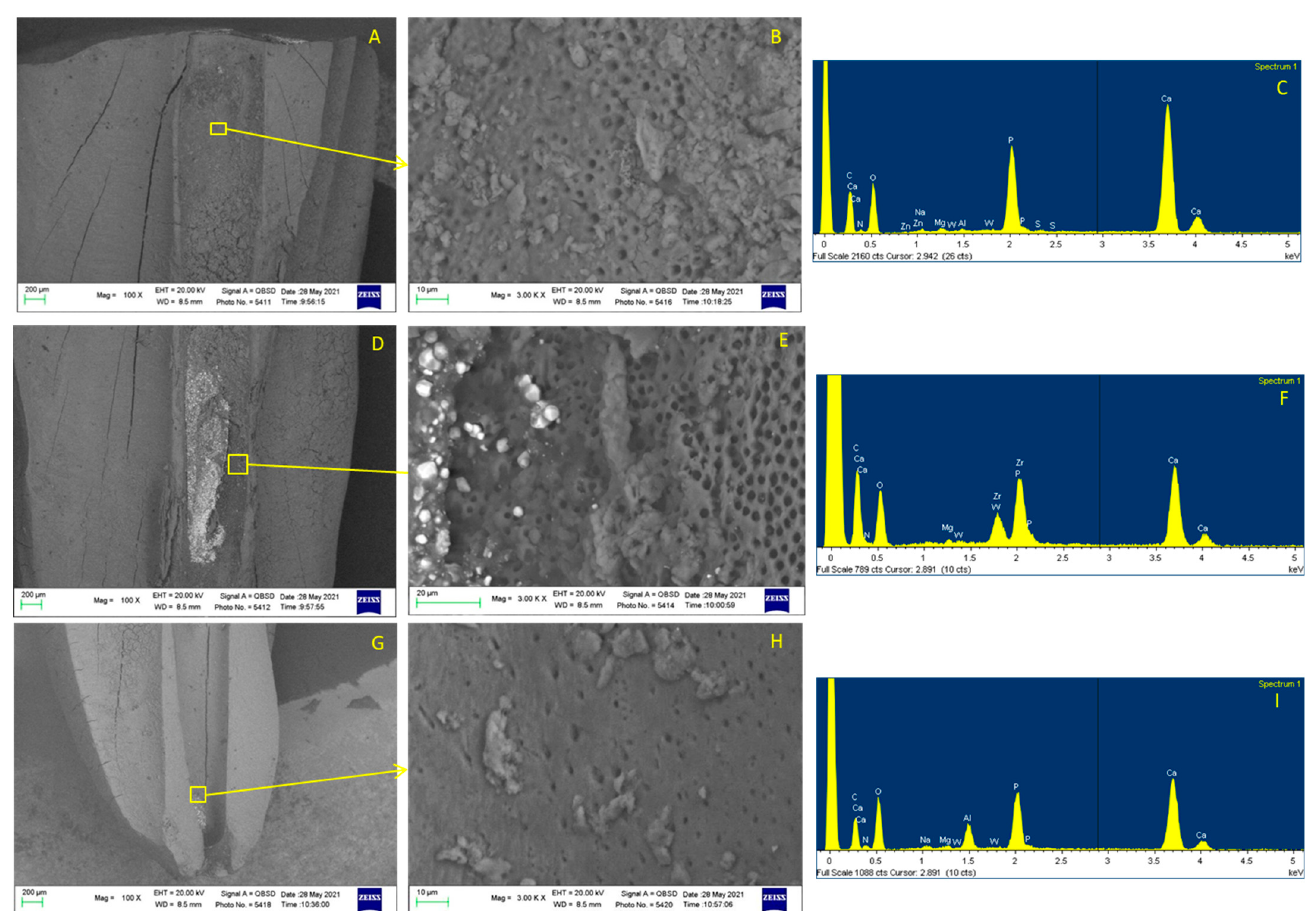
Figure 5. Root canal obturated with SC technique, sectioned and examined with ESEM/EDX. Coronal third examination at 100 × ( A ) revealed a few electron-dense granules on the dentinal surface. Dentinal tubules at 3000 × were partially occluded by smear layer ( B ). EDX microanalysis showed the presence of tracer elements that can be attributed to the sealer (W) and gutta-percha cone (Zn) ( C ). Dentine surface at the middle third at 100 × ( D ) was characterized by a thick layer of remnants. Image at 3000 × ( E ) shows an irregular layer with some areas filled by electron dense remnants, and few areas with limited remnants. EDX ( F ) revealed high peaks of elements attributable to AH plus (W) and gutta-percha cone (Zn, and Si). N, index of collagen was not detected in this area. Dentine surface at the apical third ( G ) was partially free from remnants. At 100 × displayed few thin layers of remnants close to the anatomical apex. At 3000 × revealed dentine surface with a few remnants ( H ). In this area, the tubules were mostly open and well visible. EDX microanalysis revealed low presence of sealer tracer elements (W) and no gutta-percha tracing elements ( I